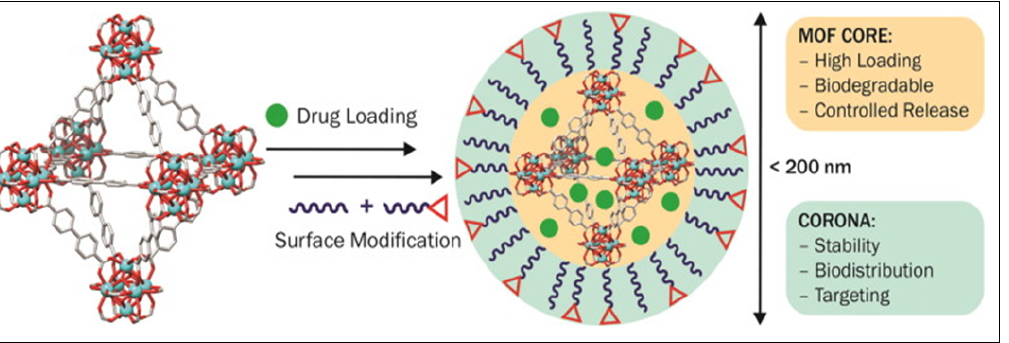
Figure 4. Surface modification of MOF nanostructures. Reproduced with permission from Ref. [140]. Copyright © 2018, American Chemical